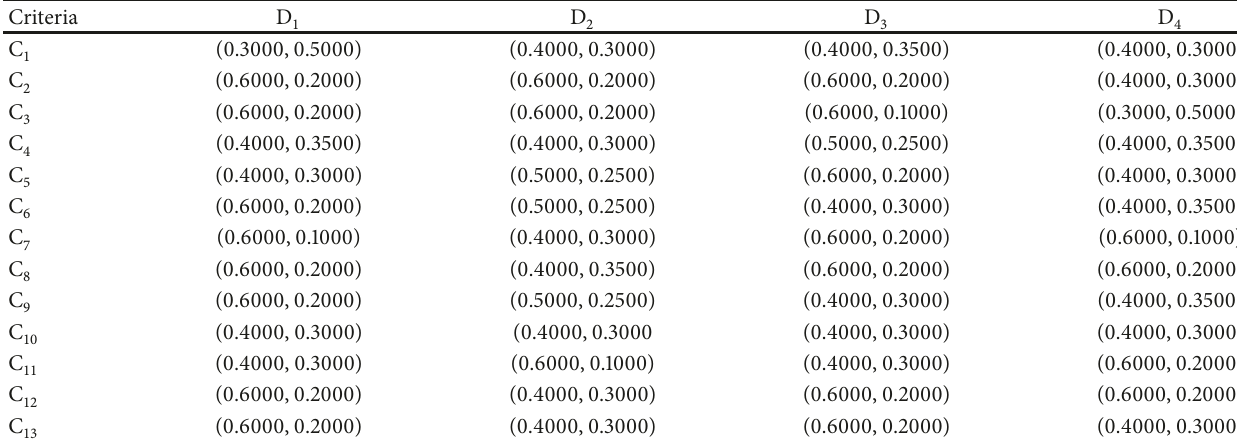
Table 7: Intuitionistic sets for the criteria importance.